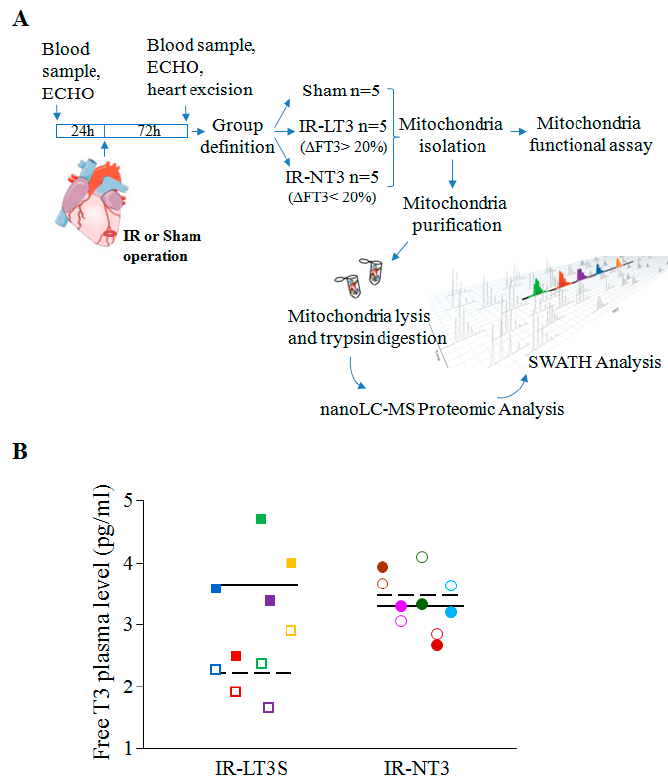
Figure 7. ( A ) Flow chart showing the study design. Seventy-two hours post IR, five rats developed a low T3 state (IR-LT3S) while 12 maintained normal FT3 plasma levels (IR-NT3 group). All five rats of the IR-LT3S group were used, and for a balanced statistical analysis between groups of equal numbers, five were randomly enrolled out of the 12 IR-NT3 rats; ( B ) Scatter-plot showing FT3 plasma levels in the IR-LT3S group (squares) and NT-3 group (circles) at baseline (filled symbols) and three days post IR (empty symbols). Different colors represent different rats. Continuous and dashed lines indicate the mean values before and after IR respectively.